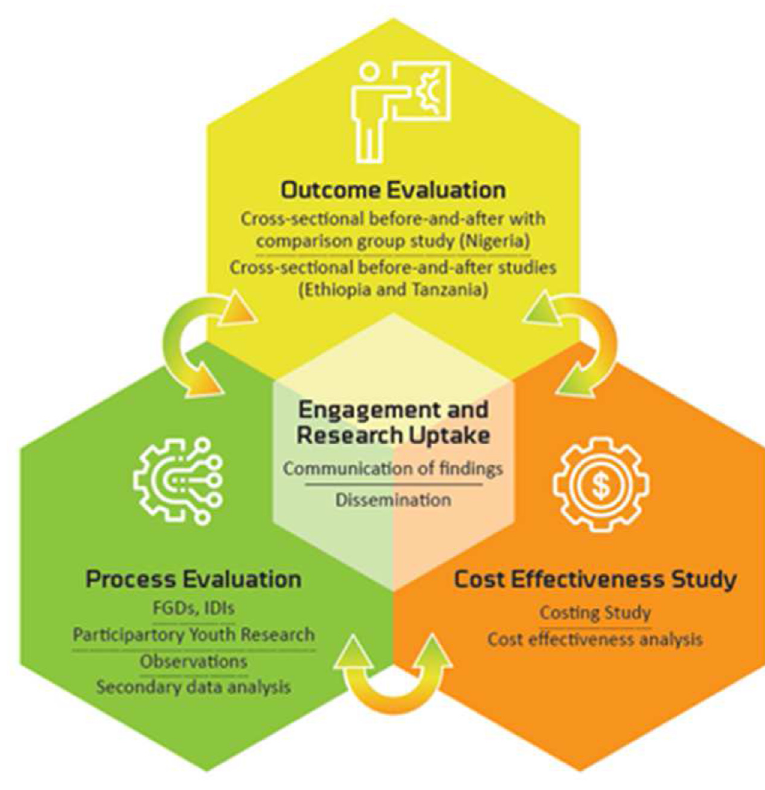
Figure 2. A360 multi-component external